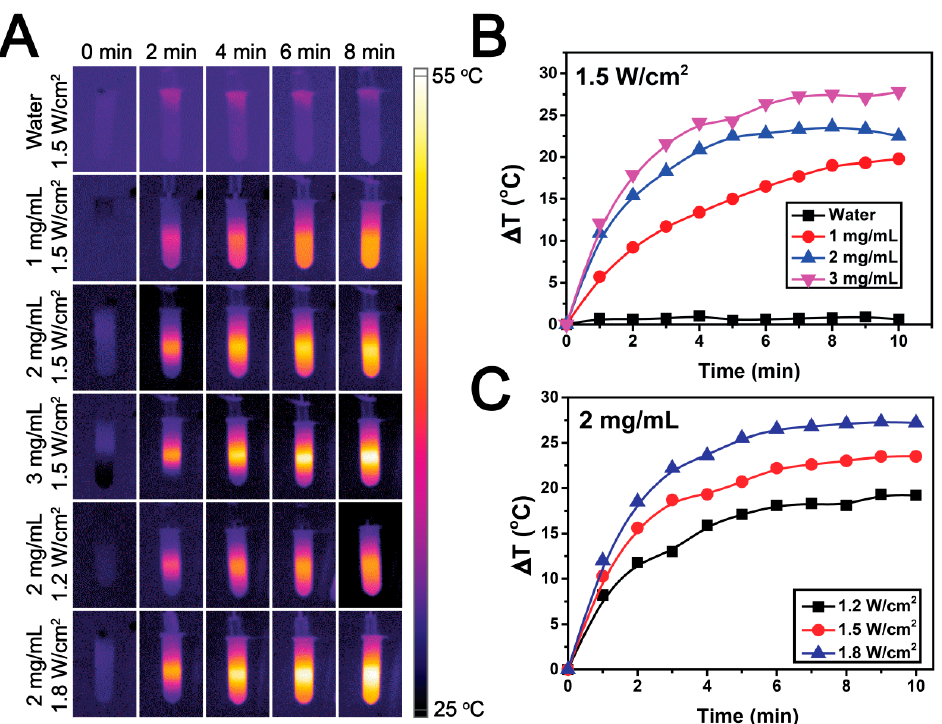
Figure 2. Temperature image of HNTs ‐ FITC ‐ ICG suspension at different concentration and under different power of 808 nm laser ( A ), temperature curve of 1 mL HNTs ‐ FITC ‐ ICG suspension at different concentrations and under 1.5 W/cm 2 of 808 nm laser ( B ), temperature curve of 1 mL HNTs ‐ FITC ‐ ICG suspension at concentration of 2 mg/mL and under different power of 808 nm laser ( C ).